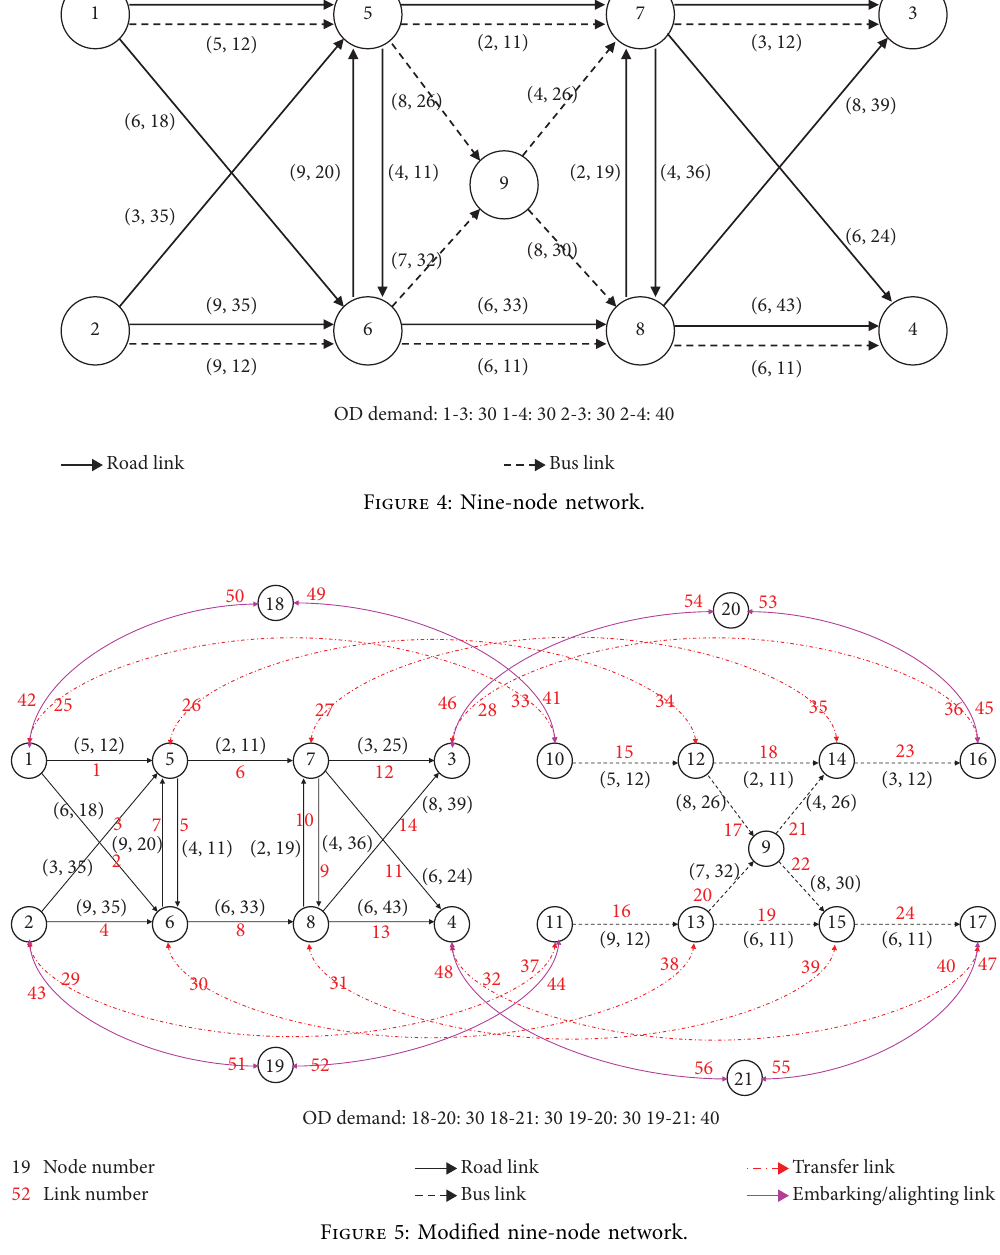
Figure 5: Modifed nine-node